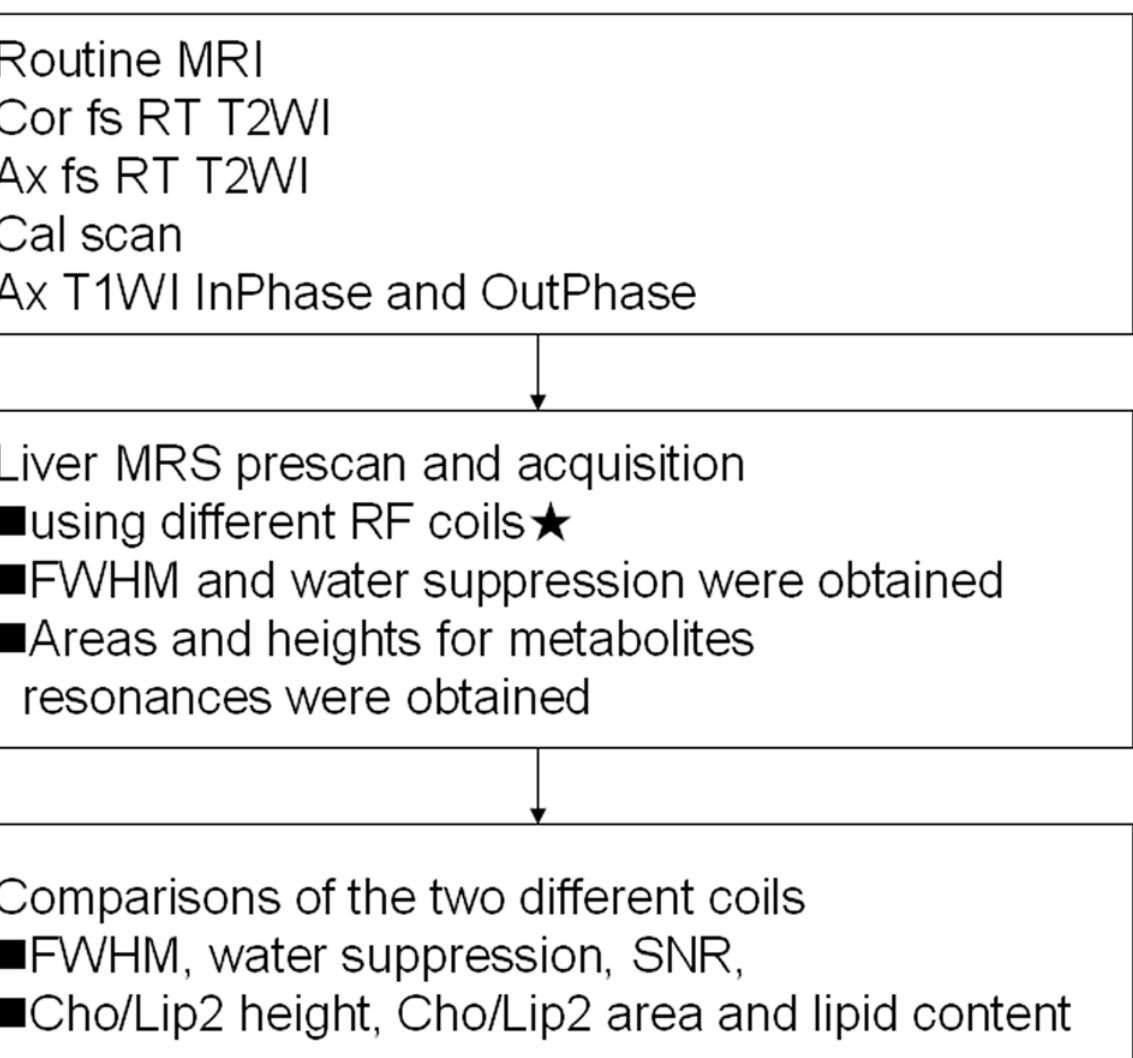
Fig 1. Detailed scanning protocols of hepatic MRS. RT = respiratory triggering; $ the first spectroscopy sequence (phased array coil was used as the receiver) was “ copied ” for the second acquisition (body coil was used as the receiver) to produce identical voxel